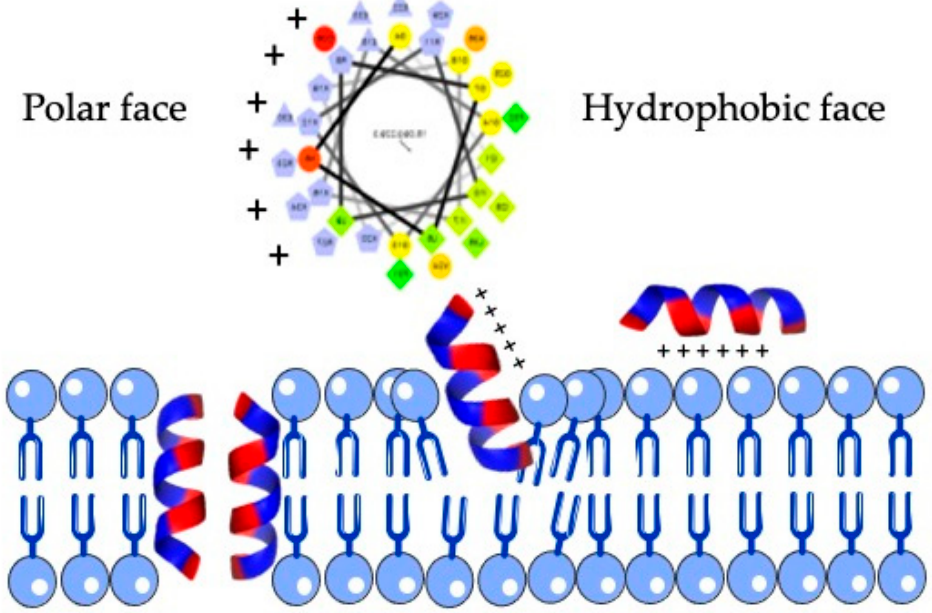
Figure 3. Structure of an amphipathic helix. Yellow/green residues of the upper helical view are hydrophobic and form the hydrophobic face, whereas purple residues of the helix are polar residues and are located at the opposite face. This feature is typical of most antimicrobial peptides and allow them to interact with membranes (down).